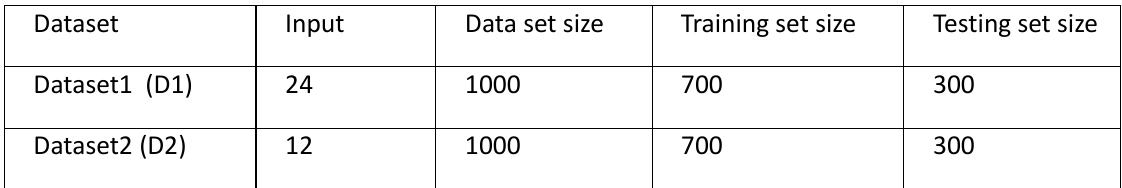
Table two: Dataset